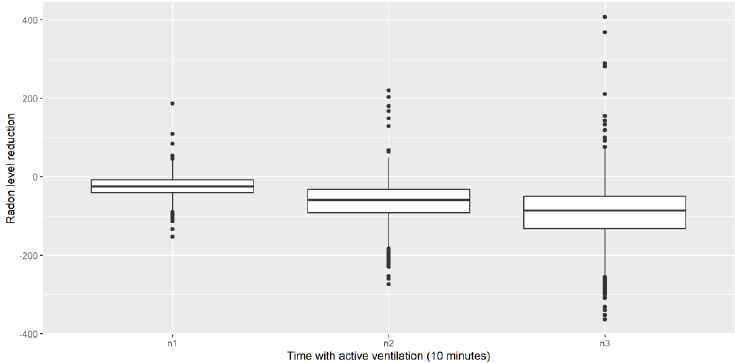
Figure 9. Radon level reduction for 10, 20 and 30 min of ventilation.